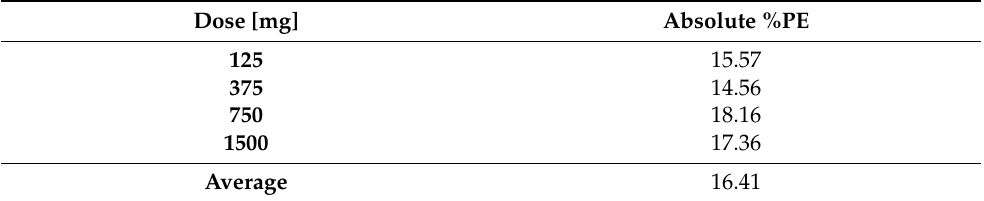
Table 9. Absolute %PEs on C max .